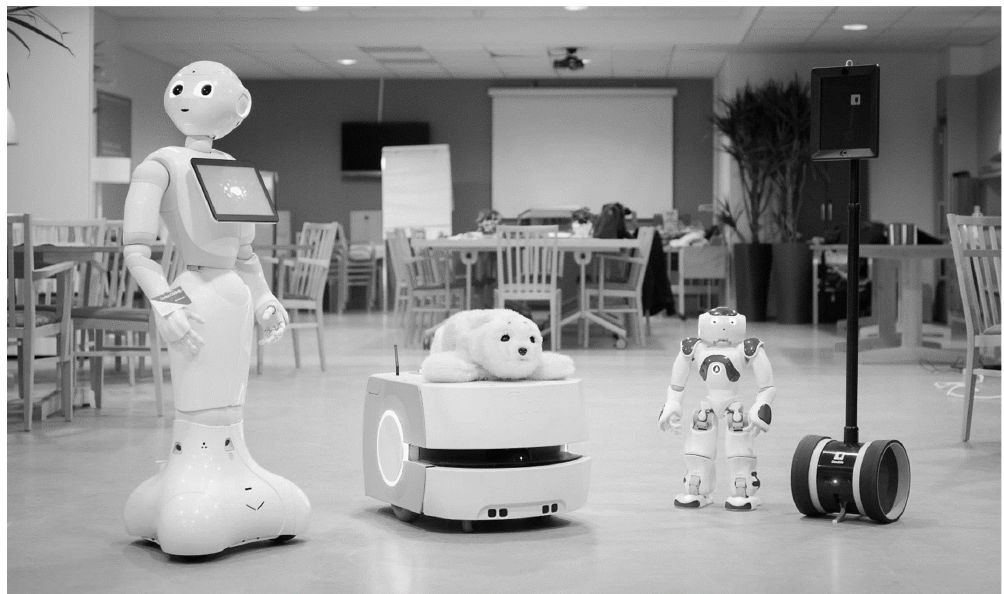
Figure 1. Robots used in the project (2nd robotics workshop in 2016).